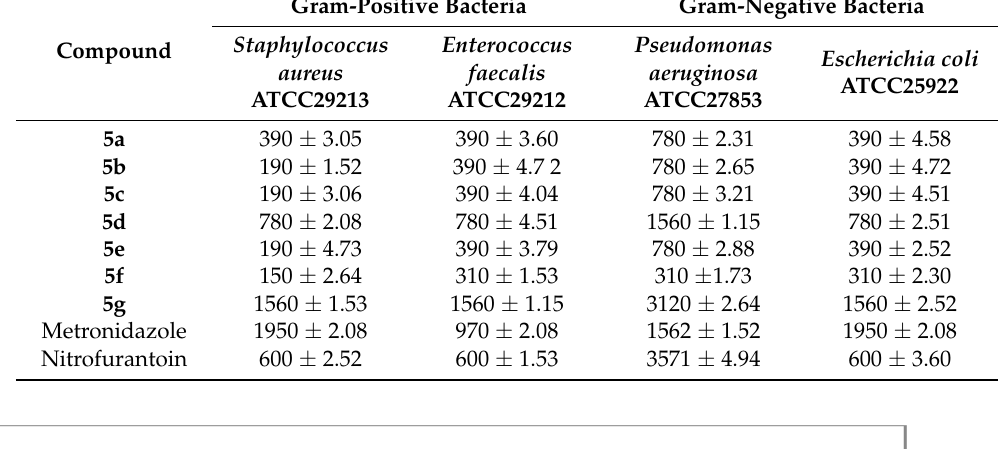
Table 3. The minimum inhibitory concentration ( µ g/mL) of test compounds 5a–g .